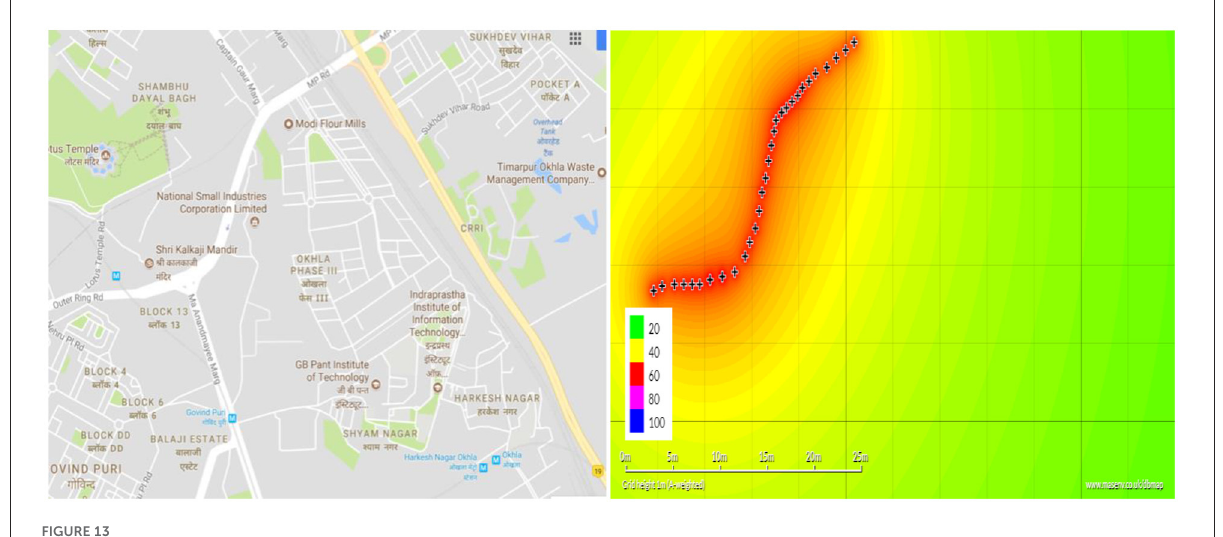
FIGURE13 2D noise mapping of industrial area.